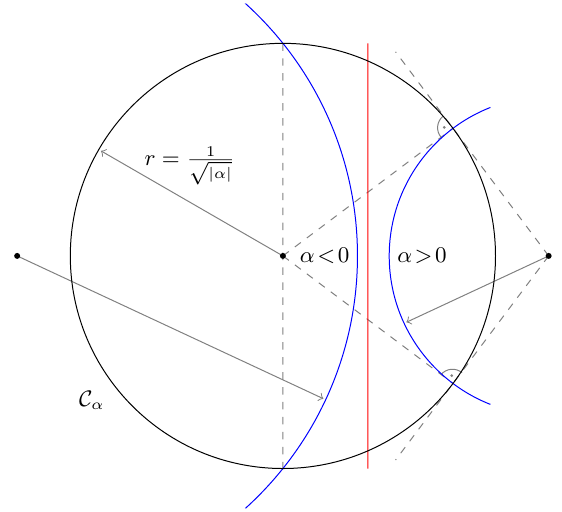
Figure 6. Distorted lines intersect C α orthogonally for α > 0 and antipodally for α < 0